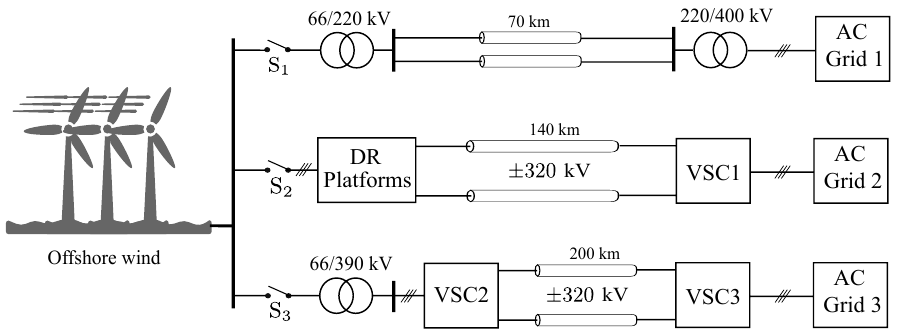
Figure 1. Overview of the studied system. VSC,